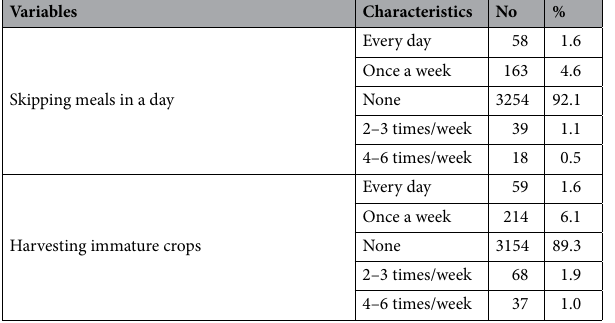
Table 6. Coping strategies of non-resilience during COVID-19 pandemic and public emergency, Northwest Ethiopia,